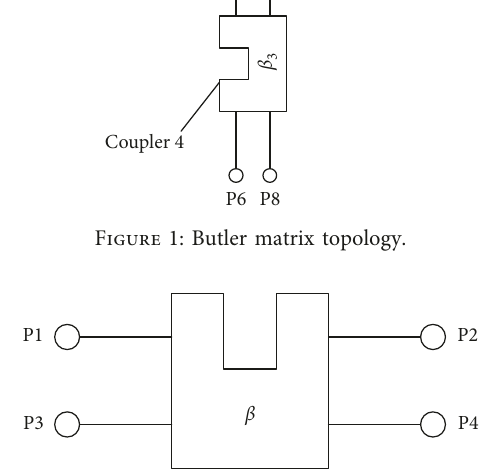
Figure 2: Coupler with β phase difference.